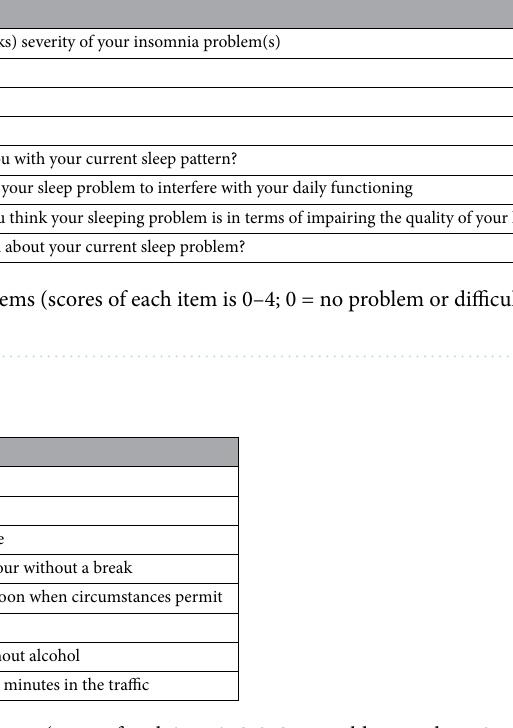
Table 2. Epworth sleepiness scale items (score of each item is 0-3; 0 = would never doze; 3 = high chance of dozing).